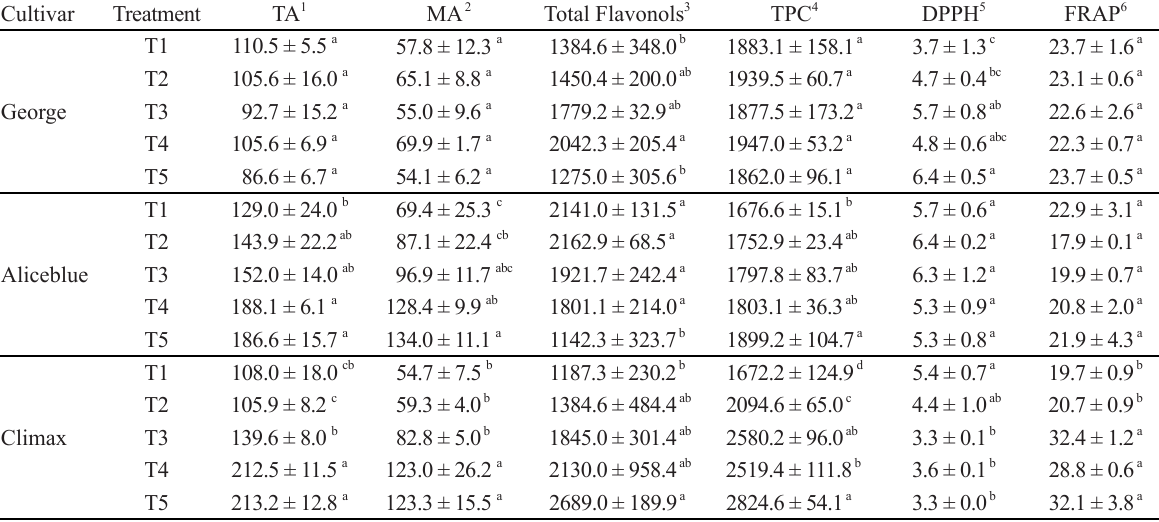
Total and monomeric anthocyanin, total flavonols, phenolic content, and antioxidant capacity of blueberry wines. Cultivar